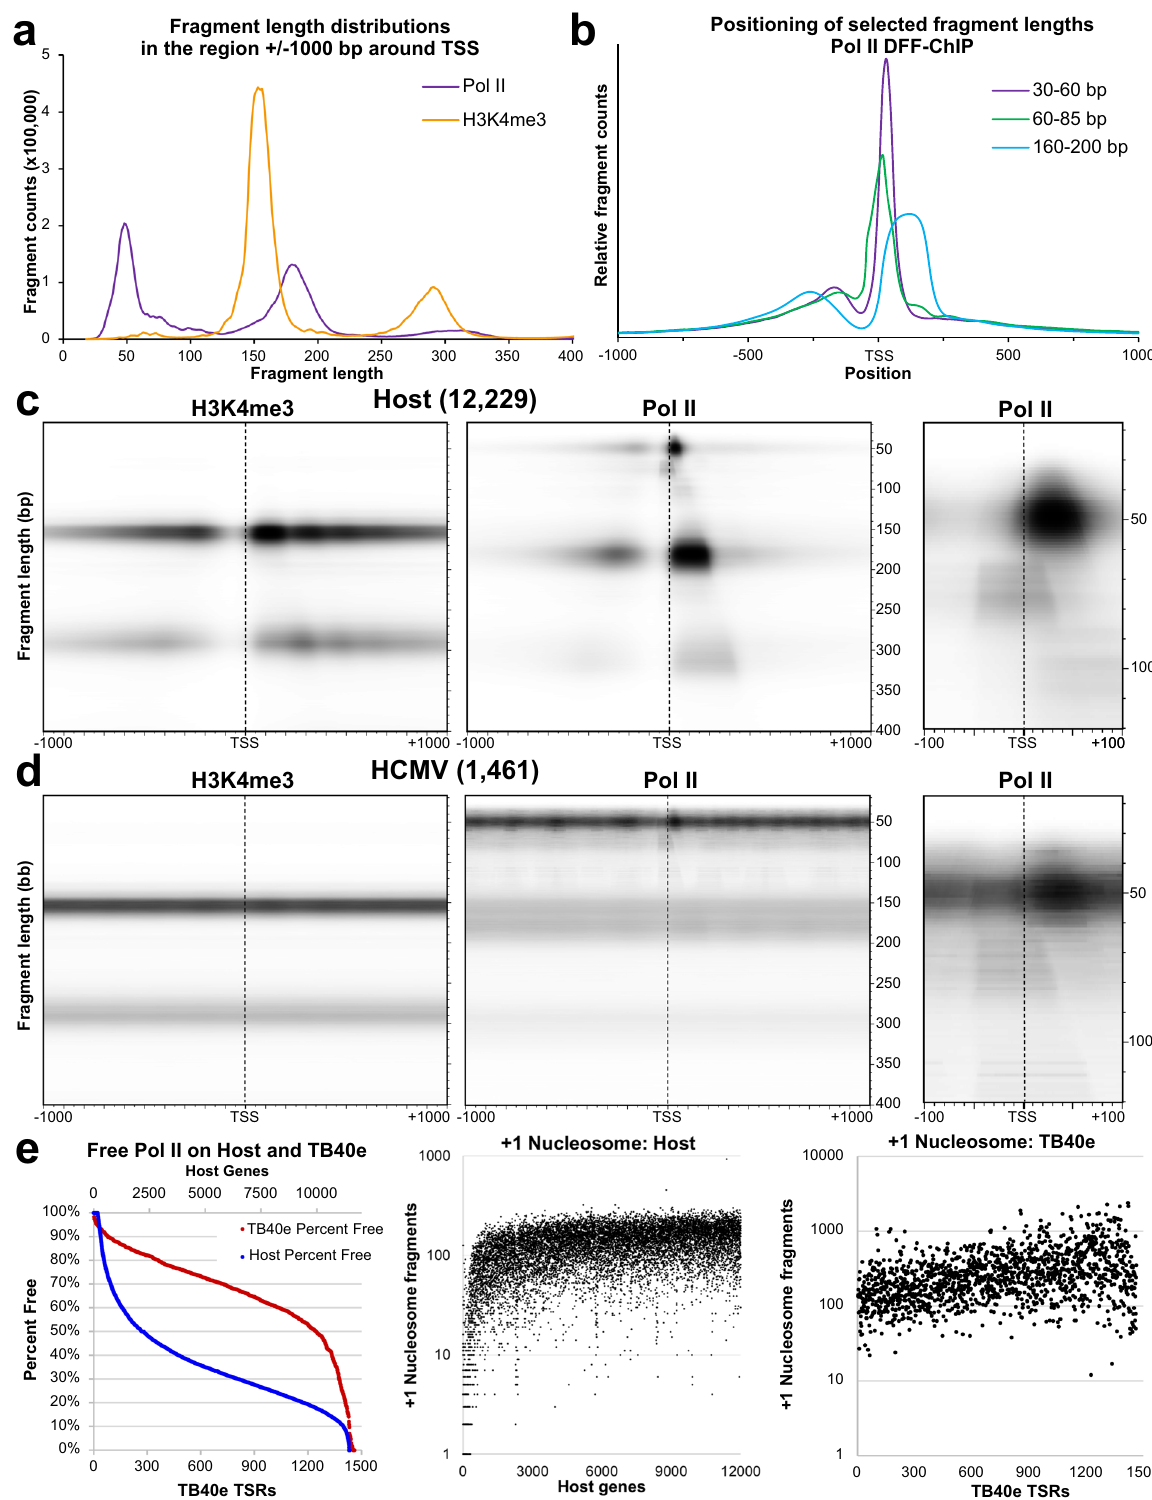
recovery of the IP, absolute amounts of visible complexes should only be compared within the same fragMap. FragMaps for the Pol II and H3K4me3 Exp4 datasets generated a snapshot of transcription complexes and chromatin features on the host and HCMV genomes. Host H3K4me3 fragMaps show very well positioned nucleosomes relative to the TSS and a clear NDR (Fig. 3c). This patterning of H3K4me3 marked nucleosomes